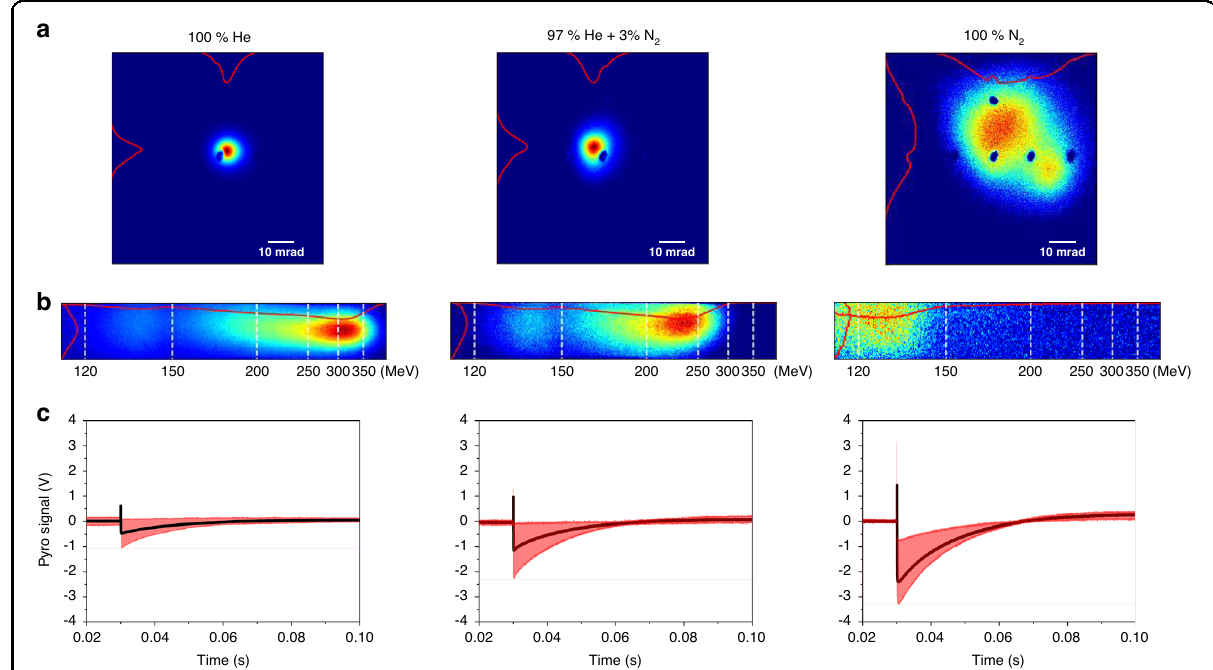
Fig. 2 Sample data taken with three different gas species — 100% helium, 97% helium mixed with 3% nitrogen, and 100% nitrogen. a Electron beam pro fi les imaged by Lanex 1. b Electron energy spectra taken with Lanex 2. c Pyroelectric signals taken with an oscilloscope, with the black and red lines representing the averaged and minimum/maximum traces, respectively. In ( a ), the dark dots are coordinate points pen-marked on Lanex